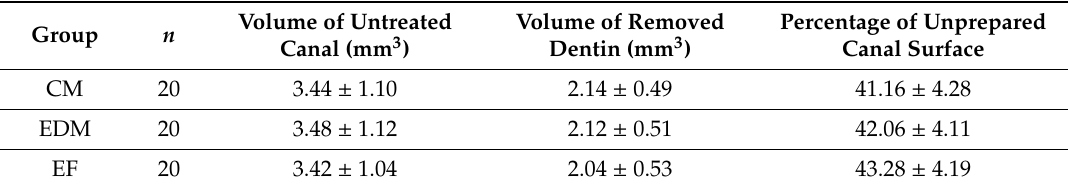
Table 1. Three-dimensional (3D) morphometric parameters between three file systems evaluated (mean values ± SD).